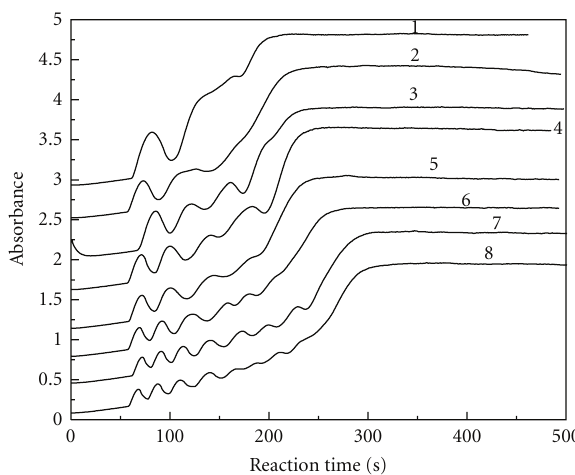
Figure 5: The absorbance versus reaction time at 289nm for the tri- iodide ion: [MAA] 0 = 6.29 × 10 − 3 mol/L, [KI] 0 = 3.82 × 10 − 3 mol/L, [ClO 2 ] 0 = 3.86 × 10 − 4 mol/L, [H 2 SO 4 ] 0 = 3.50 × 10 − 3 mol/L (curve 1), 4.21 × 10 − 3 mol/L (curve 2), 4.91 × 10 − 3 mol/L (curve 3), 5.61 × 10 − 3 mol/L (curve 4), 6.31 × 10 − 3 mol/L (curve 5), 7.01 × 10 − 3 mol/L (curve 6), 7.71 × 10 − 3 mol/L (curve 7).